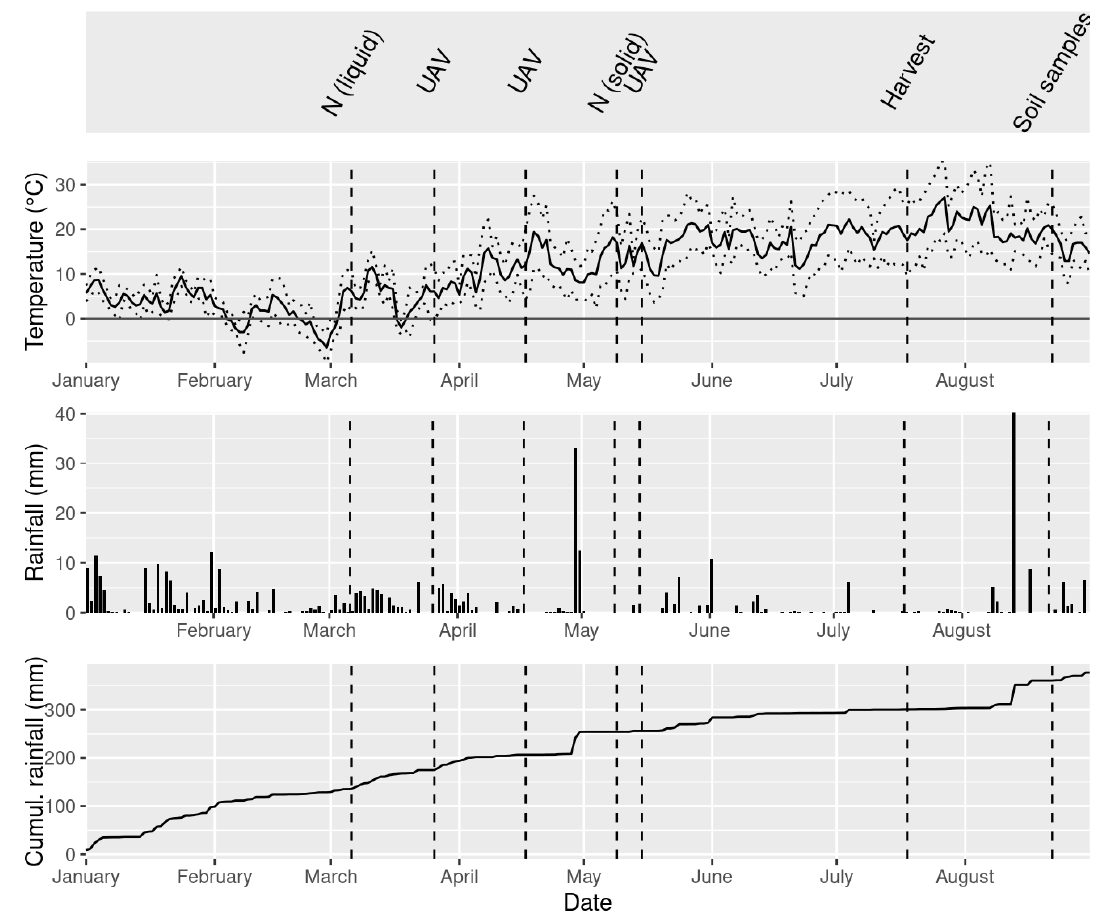
Figure 2. Timeline from 1 January to 31 August 2018 of daily meteorological data (temperature, rainfall, cumulative rainfall), UAV flights occurrences, fertilizer N applications, harvest, and soil sampling over the experimental field of 17 ha located in Gembloux (Belgium) for the present study and cropped with winter wheat. First graph represents minimum, average (continuous line), and maximum